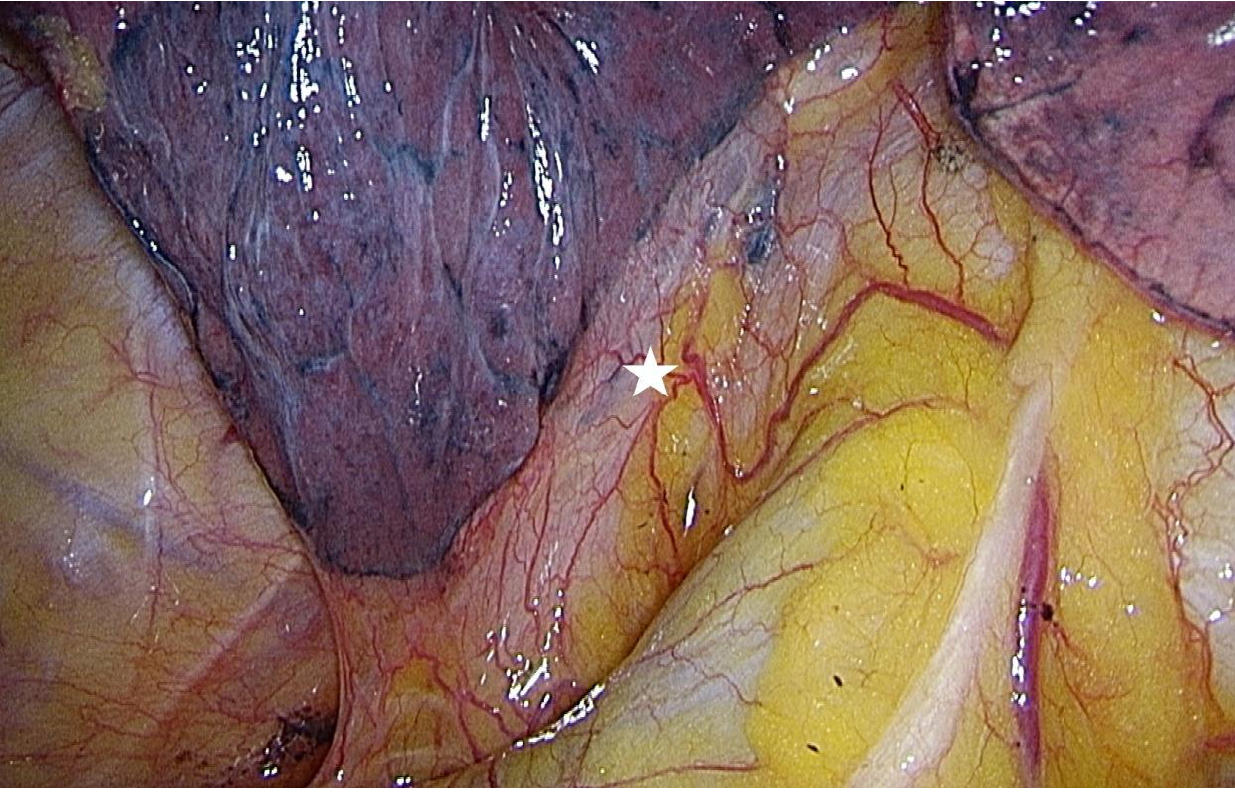
Figure 5. Lymph node station 9. Asterisk: station 9.